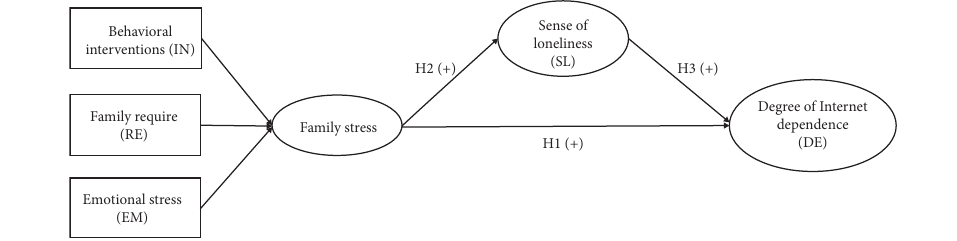
Figure 1: Theoretical model of this Table 1: Variable measurement and coding.